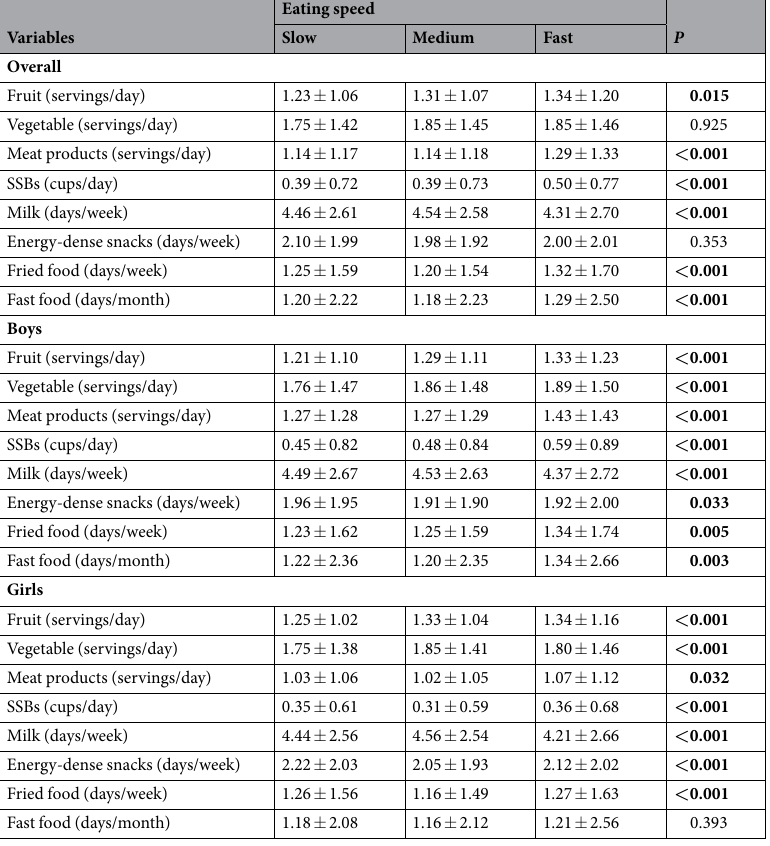
Table 4. The food frequency stratified by eating speed and gender. * All P values were adjusted for age and area. Overall P values were also adjusted for